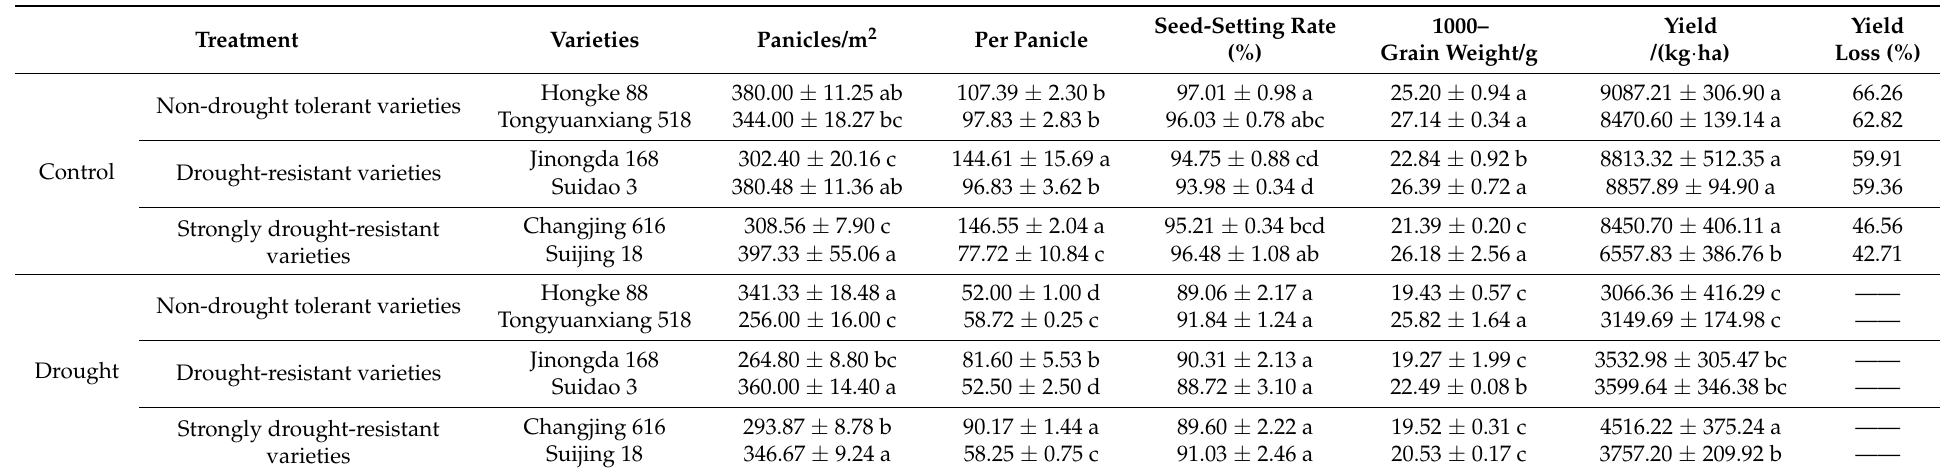
Note: Different lowercase letters indicate significant differences at p <